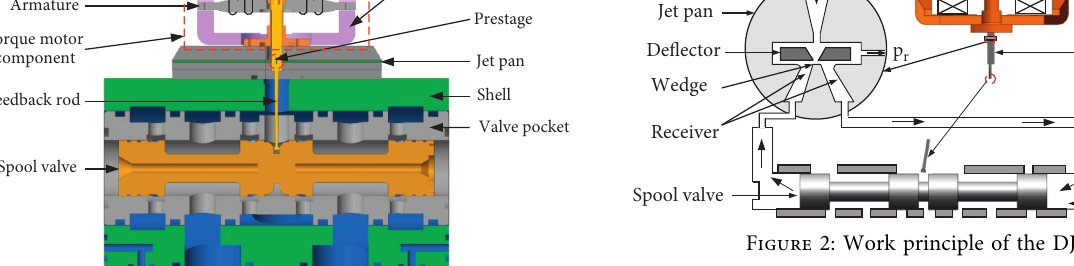
Figure 2: Work principle of the